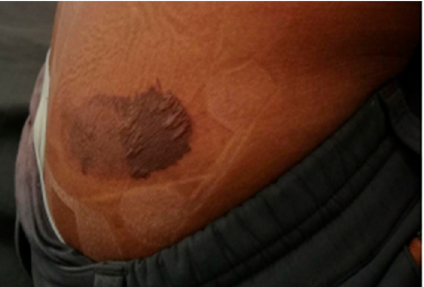
Figure 1. A picture of the friction blister on the 24-year-old, Mt. Everest guide, after a week of medical care [6]. Reproduced with permission from Adhikari, S.; Dawadi, S.; Upadhyay, J., Friction Blister by Climbing Harness: A Case Report; published by Elsevier,